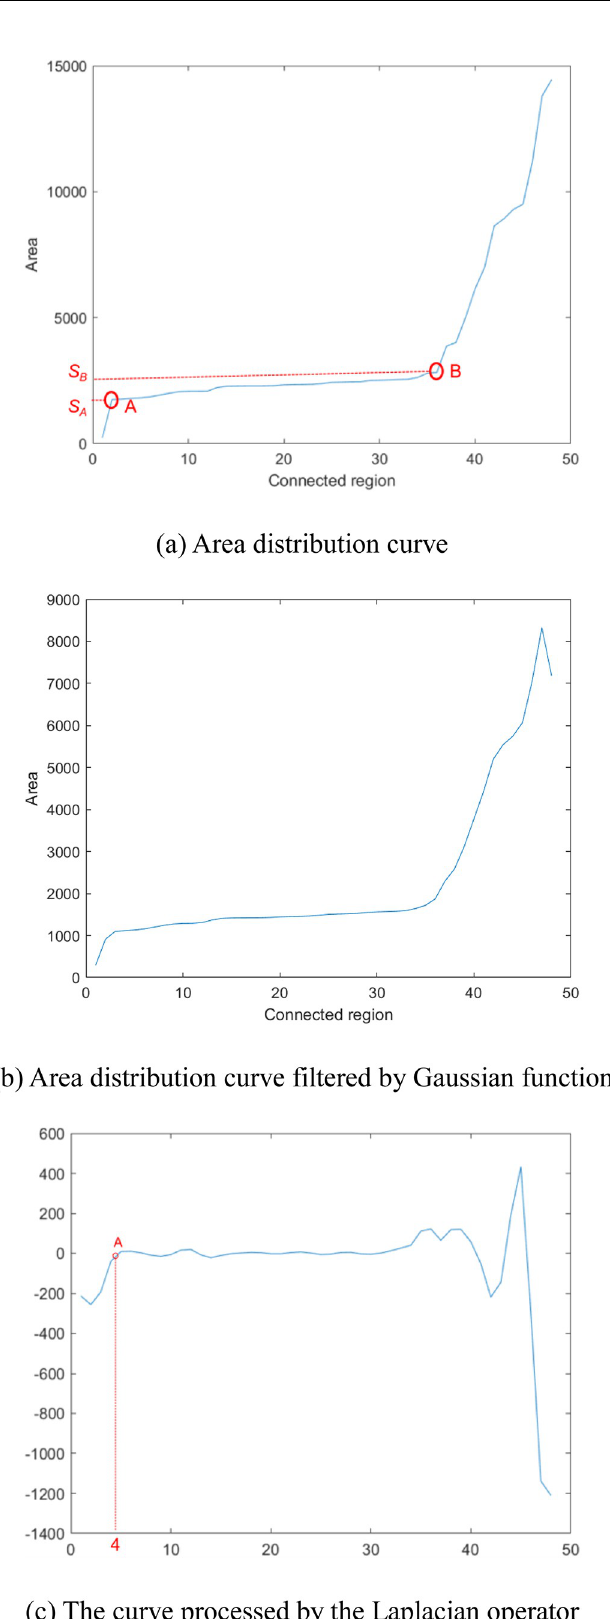
Fig 6. Determine the area of a single